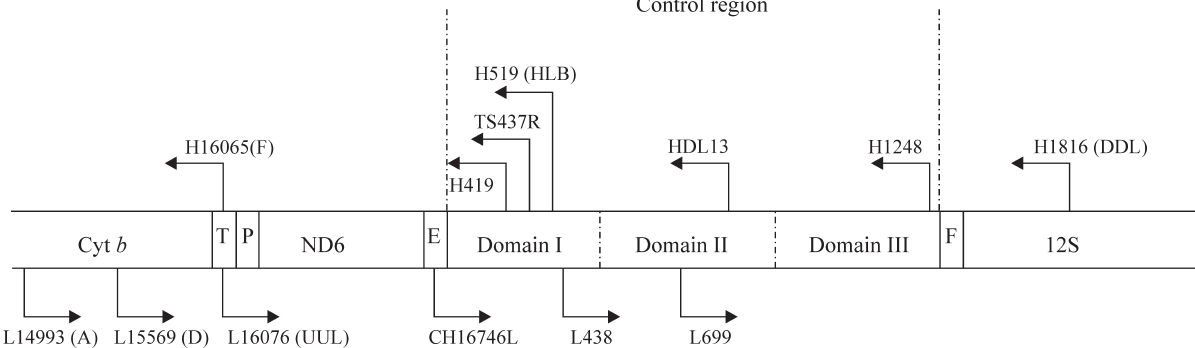
Figure 1 - Schematic diagram showing the locations of the primers used to amplify the mtDNA control